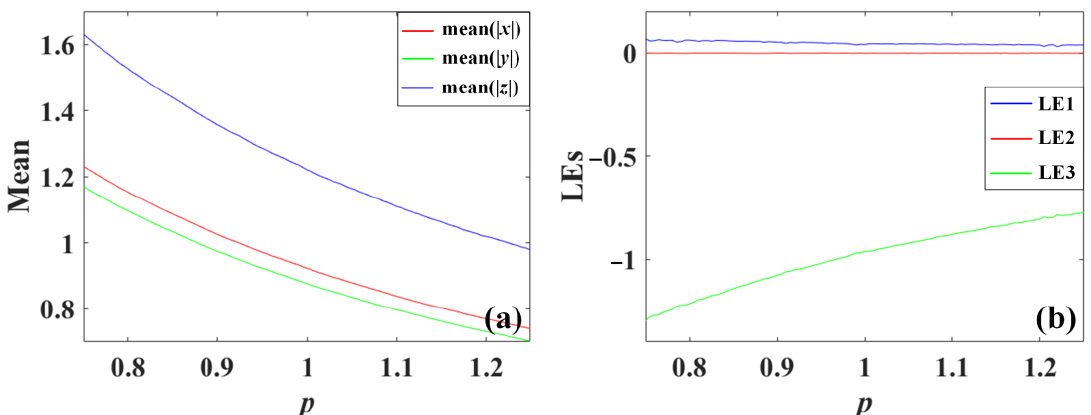
Figure 8. System (6) with a = 0.5, b = 1.1, c = 1.2 under initial condition (0, 1, 1) when m varies in [0.75, 1.25]: ( a ) average values, ( b ) Lyapunov exponents.